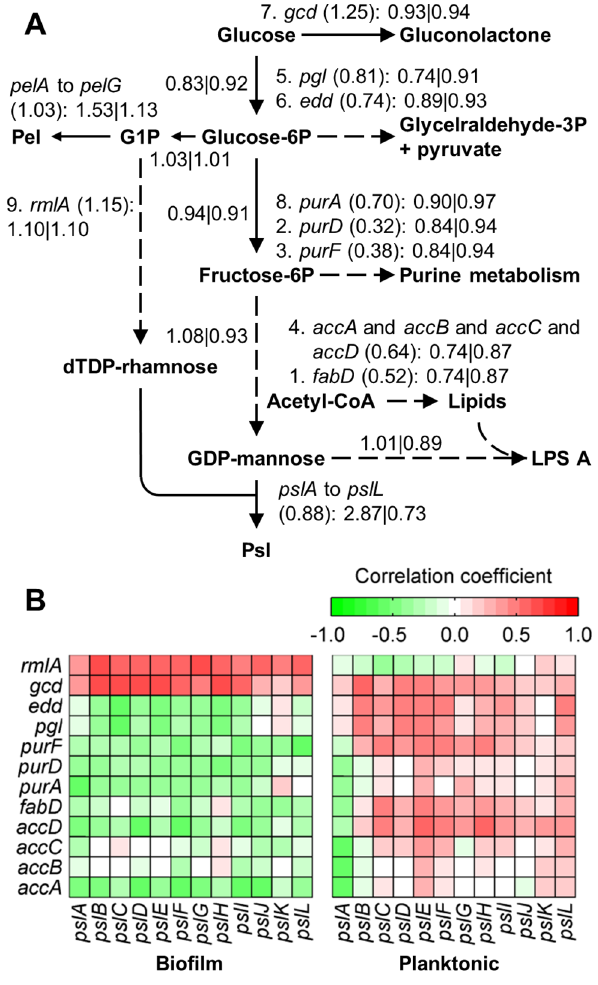
Fig 3. Coordinated regulation of Psl synthesis. (A) Sketch of the metabolic pathways involved in the increase of Psl and Pel production rates in our simulations. The figure shows the genes associated with the nine reactions that had the highest effect on Psl production. The number to the left of each gene name denotes the rank of the corresponding reaction. The number in parentheses denotes the overall gene expression ratio between the biofilm and the stationary cultures. The numbers to the left and right of the vertical bar denote the median flux ratios of the reactions associated with the genes in simulation with or without the gene expression ratios of the genes accABCD , fabD , purADF , pgl , edd , gcd , and rmlA . Only psl , pel , and those genes whose regulation contributes to increasing Psl and Pel production are shown. (B) Correlation between the expression of the genes that contribute to increasing Psl production and the psl operon genes for biofilm and stationary cultures. Solid and dashed arrows indicate single and multiple reaction steps in the model,